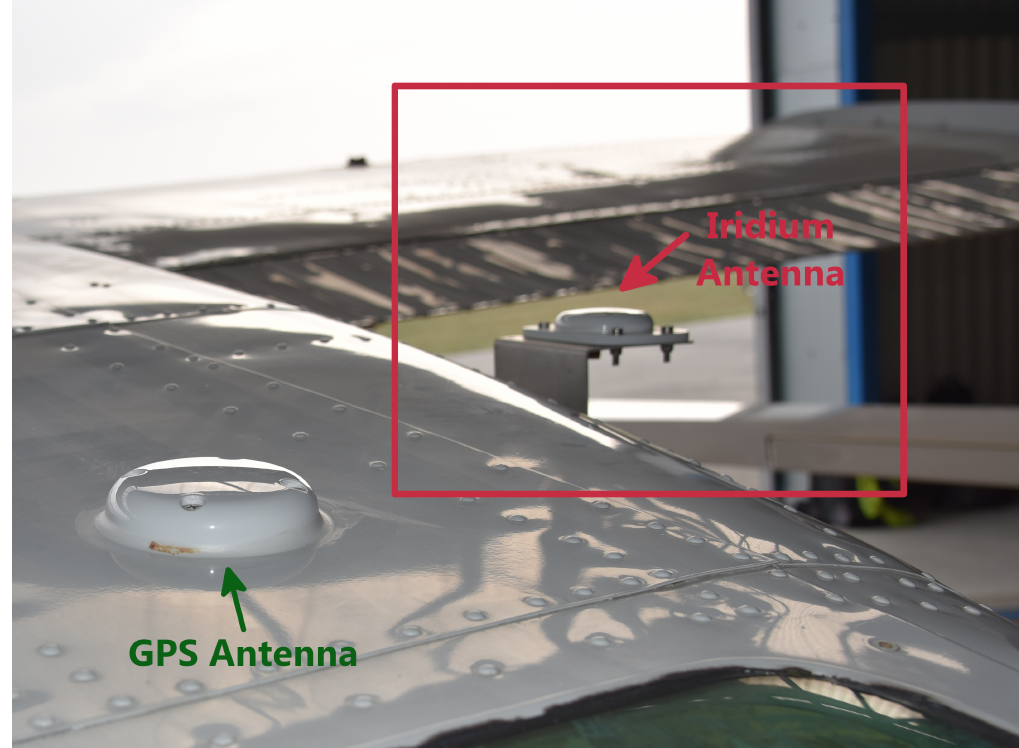
Figure 3. AeroAntenna AT2775-110 Iridium Antenna mounted on the airplane’s